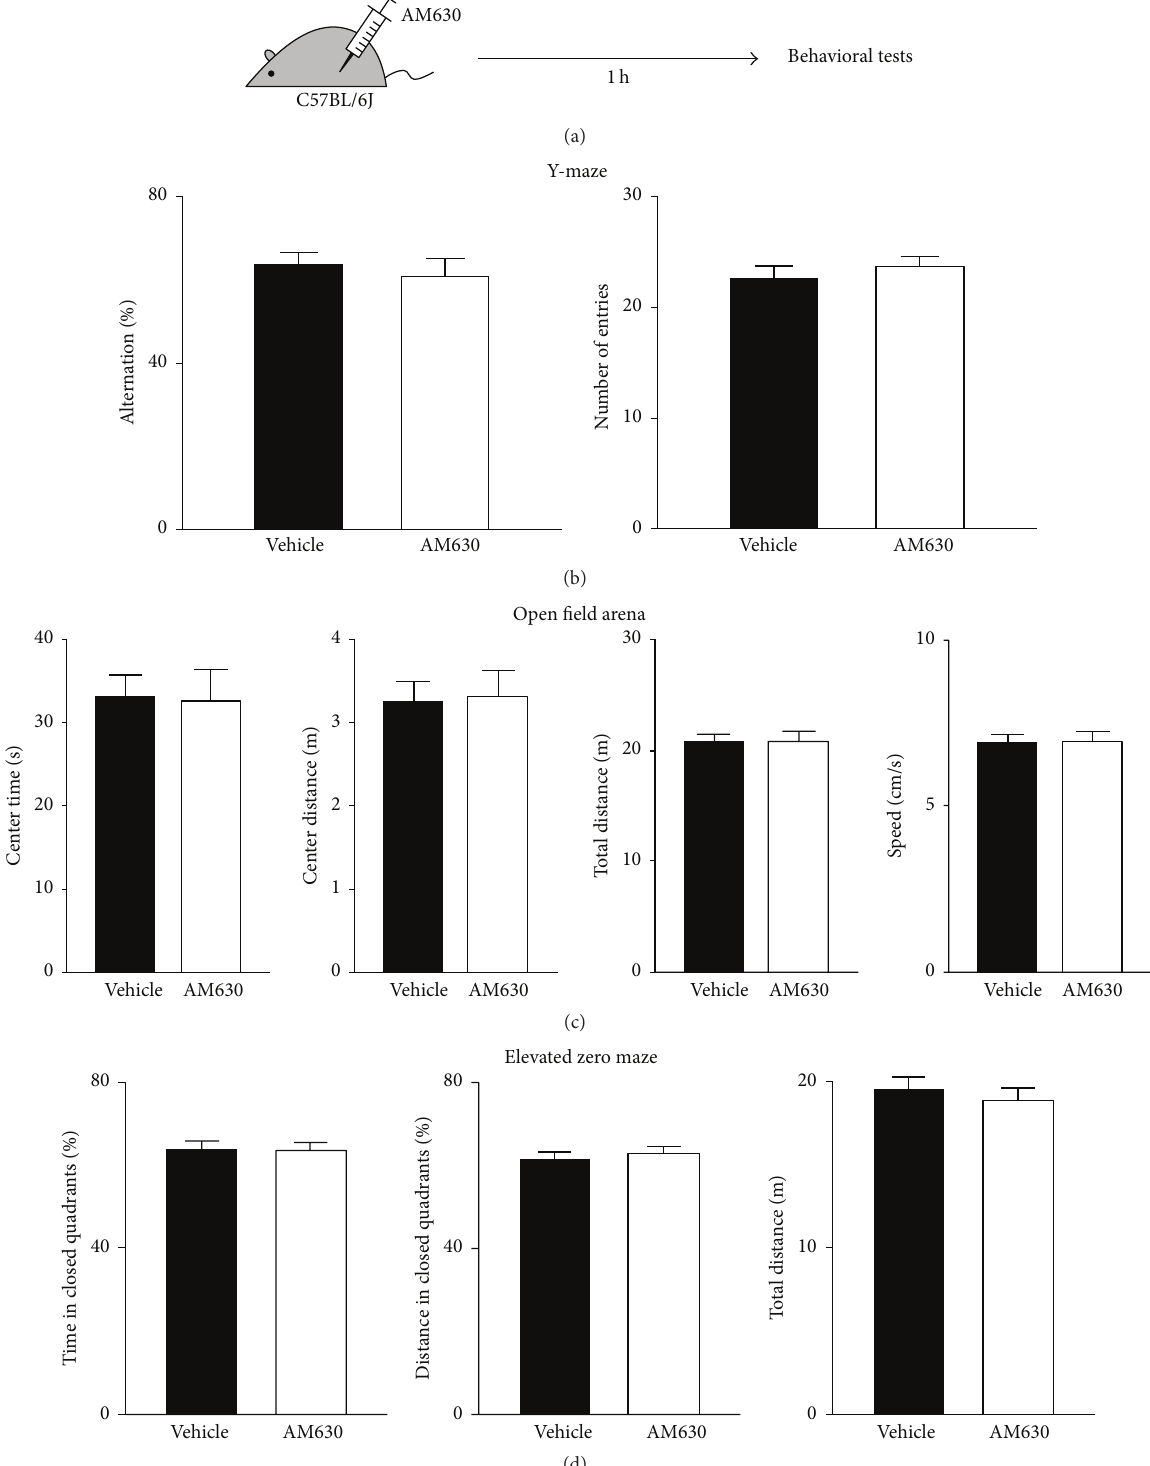
Figure 6: Acute blockade of CB2Rs had no effect on working memory, locomotion, or anxiety. (a) Adult male C57BL/6J mice were injected with AM630 (3mg/kg, i.p.) and, 1h after the injection, used for behavioral tests in a Y-maze, an open field arena, and an elevated zero maze. (b) The rate of spontaneous alternation or the number of arm entries of AM630-treated mice in a Y-maze was not different from that of control mice. (c) In an open field arena, AM630- and vehicle-injected mice displayed similar behavioral patterns in the time spent in the center area, distance traveled in the center area, total travel distance, and travel speed. (d) In an elevated zero maze, the time and distance in the closed quadrants and the total travel distance of AM630-administered mice were similar to those of control mice. Error bars represent